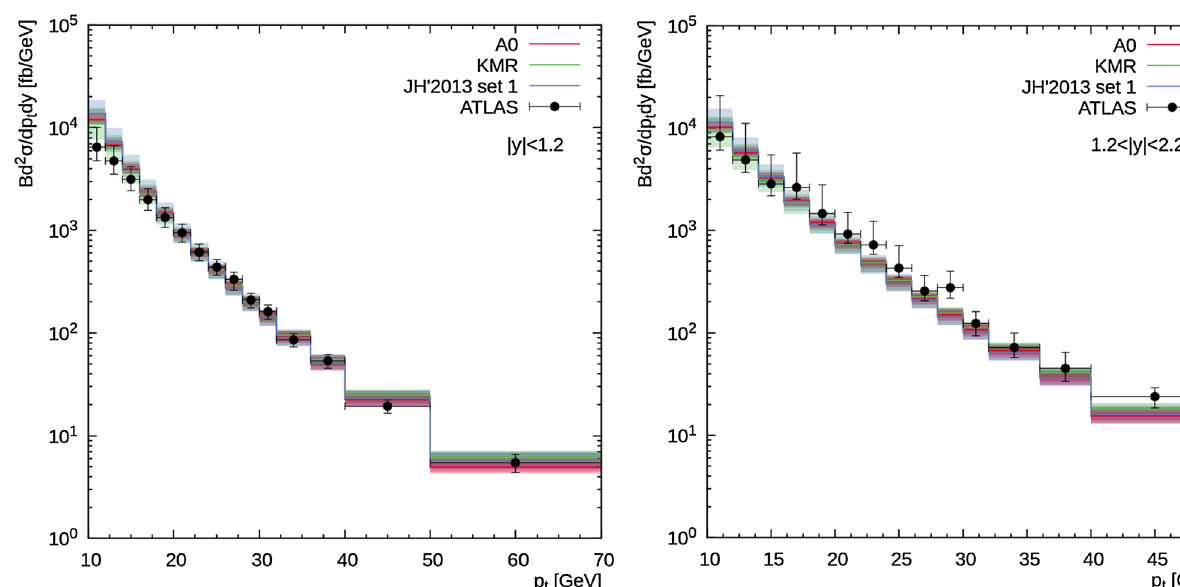
A0, KMR and JH’2013 set 1 gluon densities. Shaded bands represent the total uncertainties of our calculations, as it is described in text. The experimental data are from ATLAS